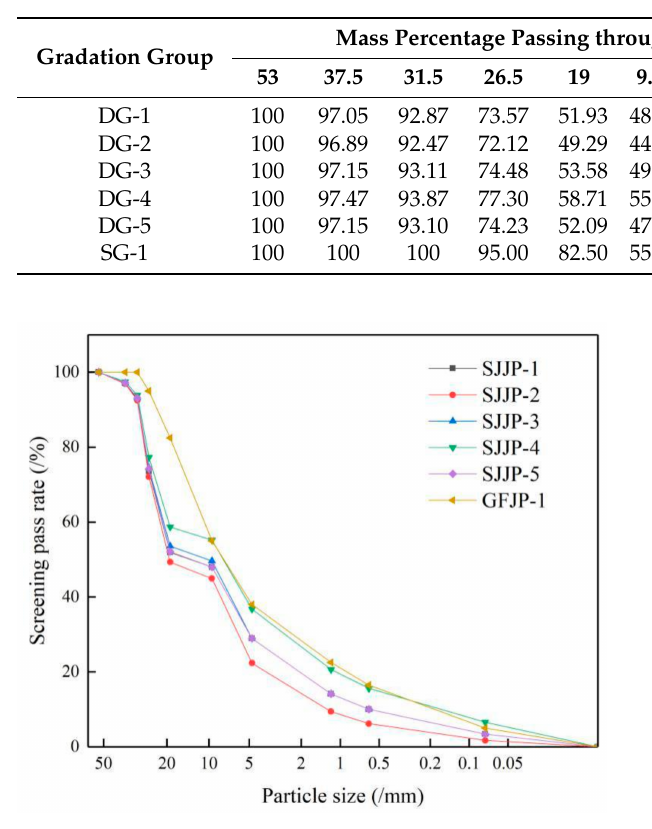
Table 2. Screening pass rate of each gradation.